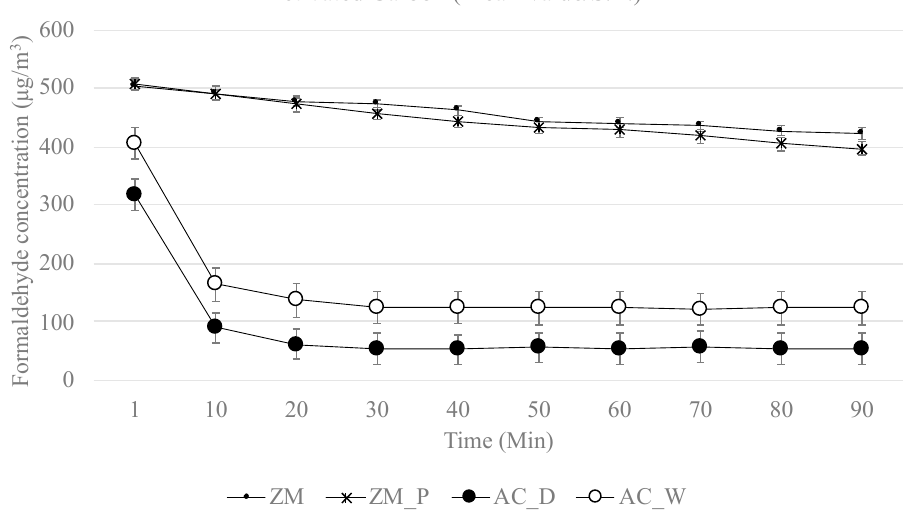
Figure 6. Measured formaldehyde concentration (( µ g/m 3 )/h) when activated carbon samples were tested: zero measurement (ZM), zero measurement with the plastic pot (ZM_P), dry activated carbon (AC_D), wet activated carbon (AC_W). Data means ± SE, n = 3 (AC_D), and n = 2 (AC_W; the third test was excluded).